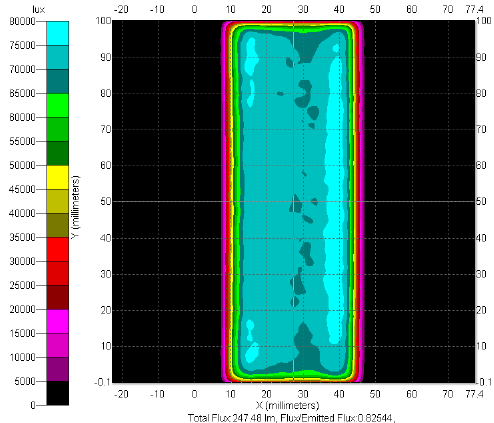
Figure 12. Illumination map for beveled reflection surface.